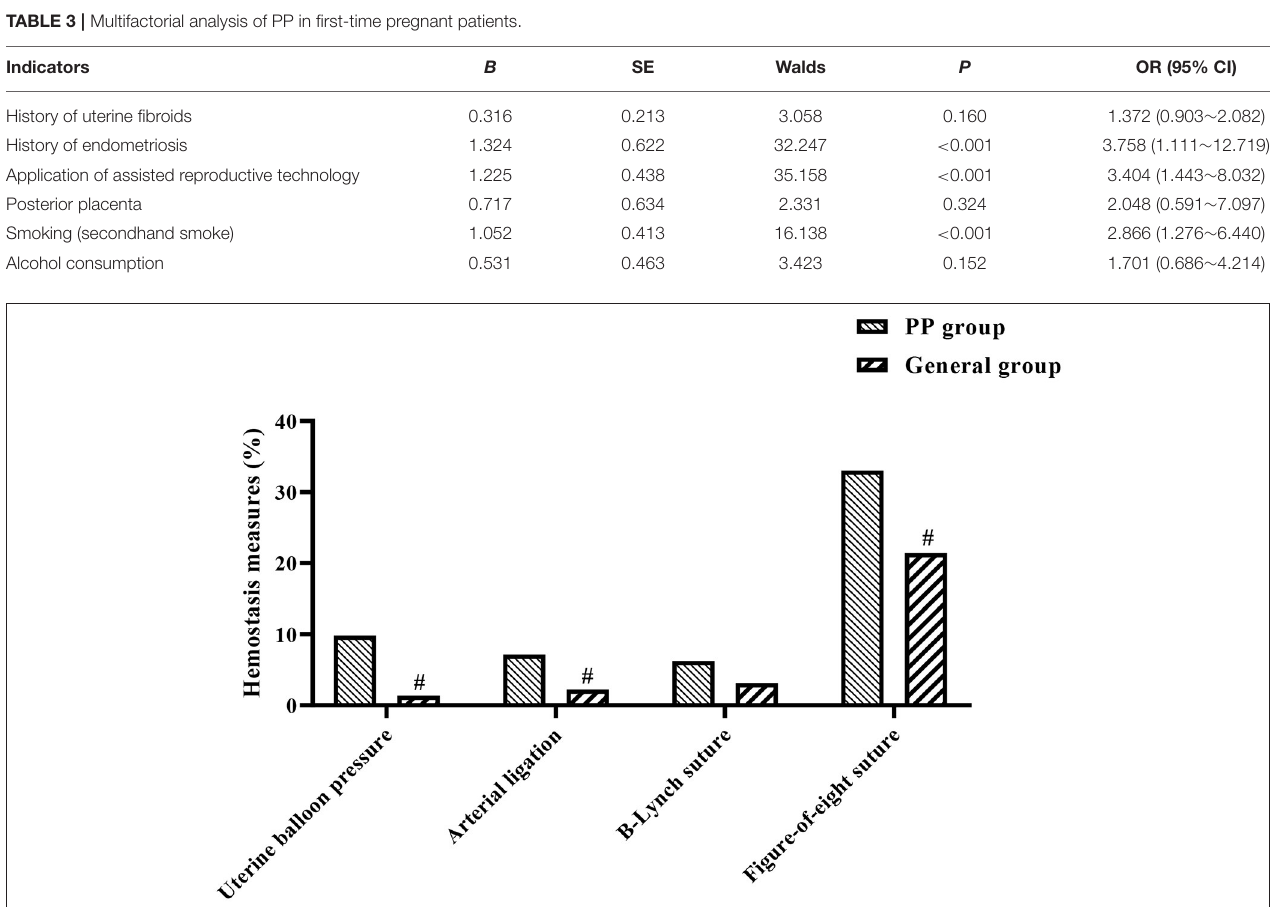
FIGURE 1 | Histogram of the implementation of hemostatic measures in both groups. # indicates comparison between two groups, P < 0.05.